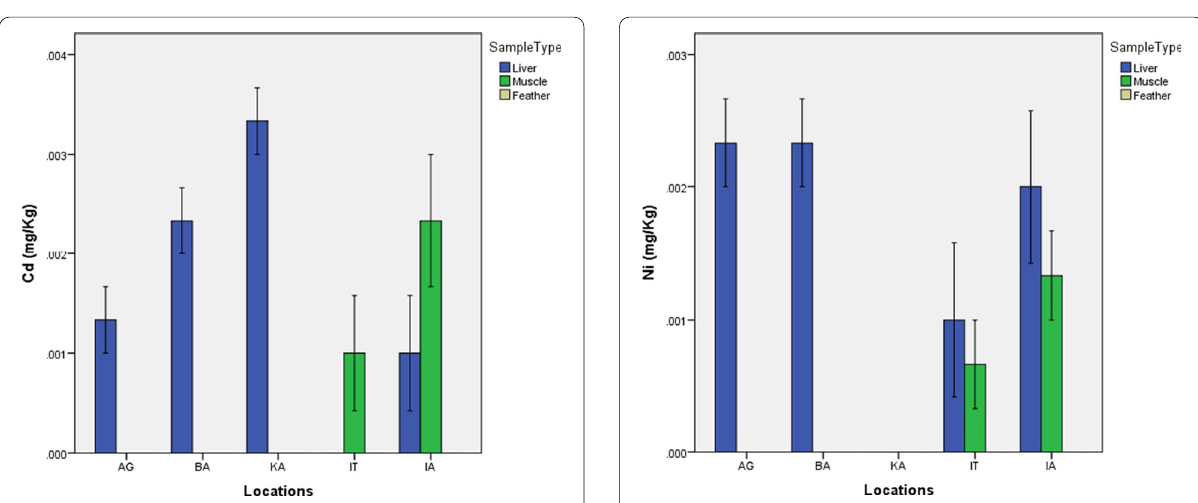
Fig. 4 Level of nickel (Ni) in sampling locations (mg/kg)